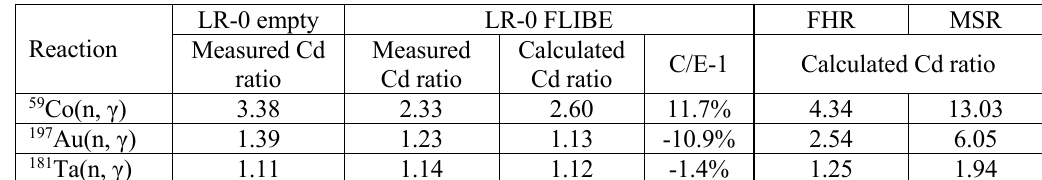
Table IV. Cadmium ratios of different thermal monitors, comparison of the reference case without insertion to FLIBE insertion